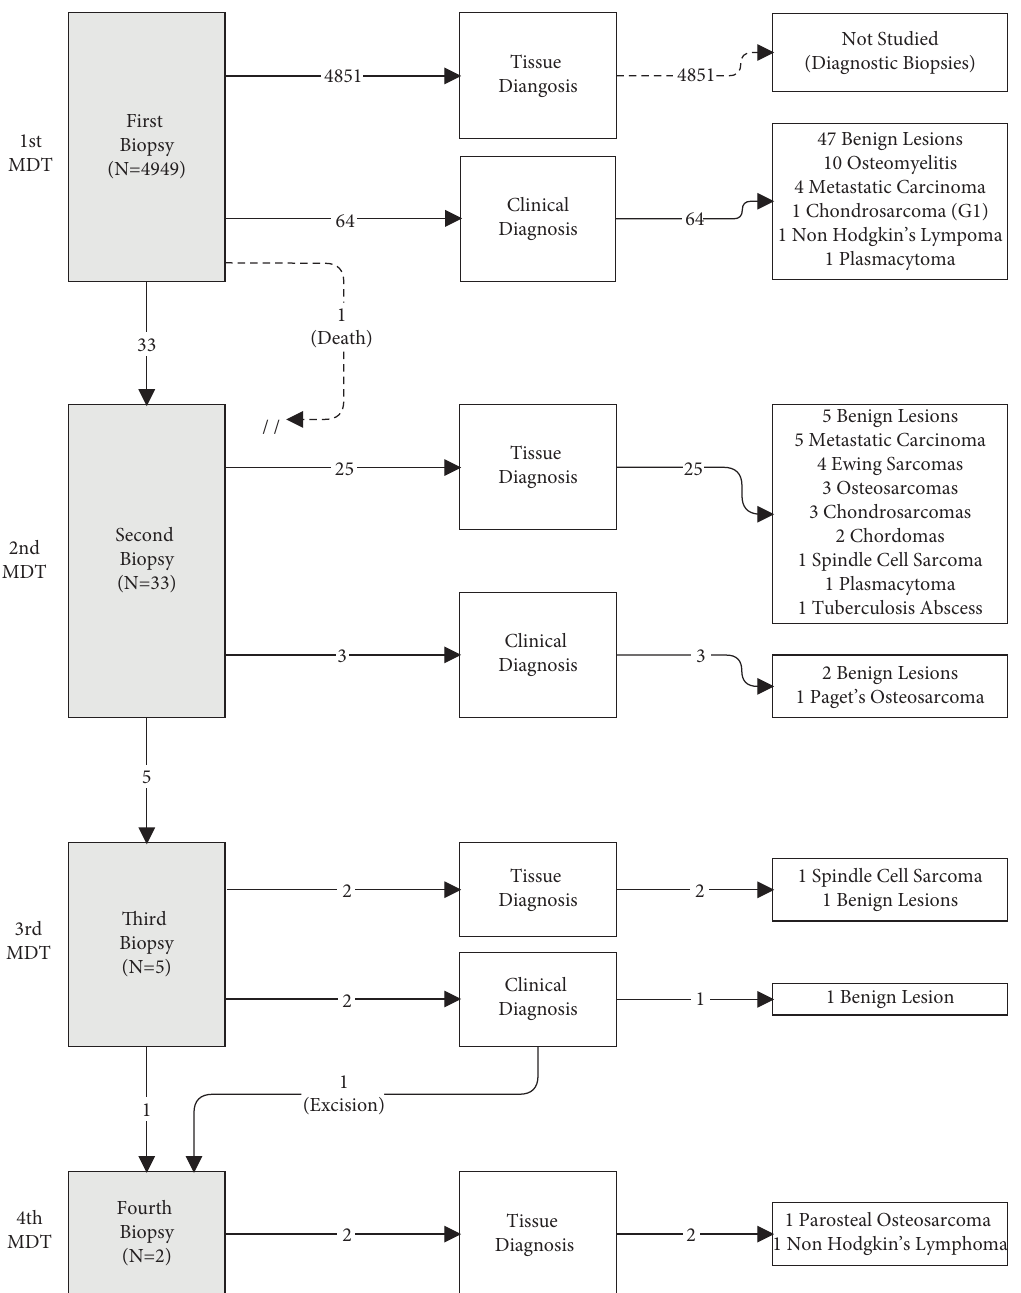
Figure 2: ND biopsy diagnosis flowchart showing how each diagnosis was reached through consecutive MDTdiscussions. Cases where the first biopsy was diagnostic were not studied, and therefore, no specific diagnoses are listed. All numbers represent